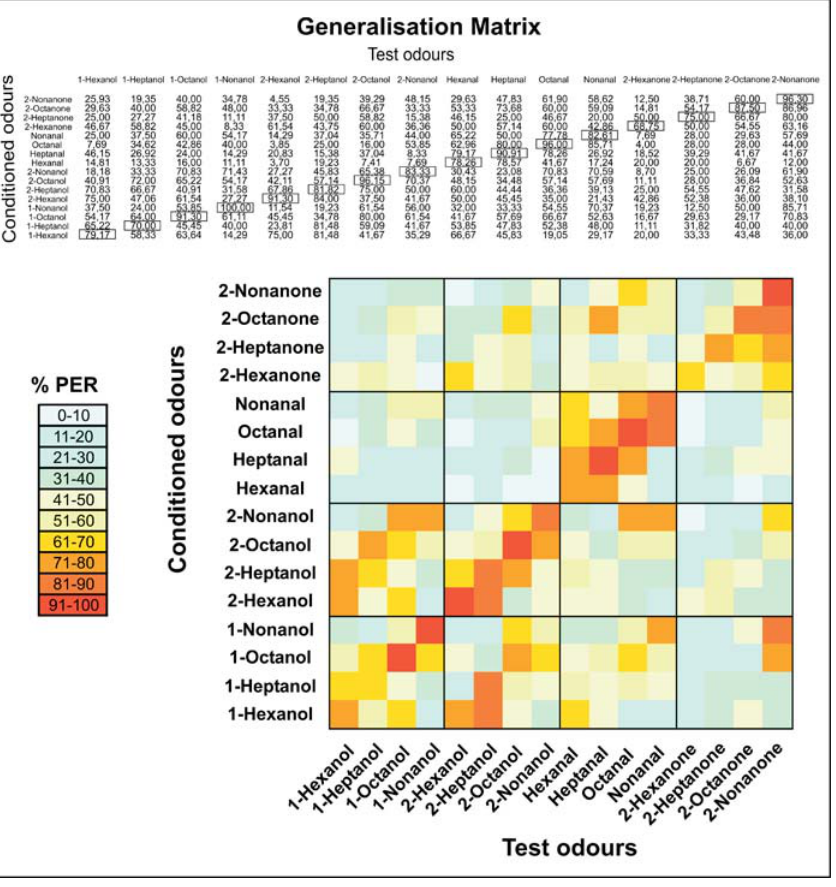
Figure 2. Olfactory Generalisation Matrix The generalisation matrix represents the percentage of PER in the tests performed by bees that actually learned the CS, that is, bees that responded to the CS at the third conditioning trial ( n = 1,457). Upper part: percentages recorded. Lower part: colour-coded graphic display grouping the level of responses in ten 10% response categories. Red, maximal response; light blue, minimal response. DOI: 10.1371/journal.pbio.0030060.g002